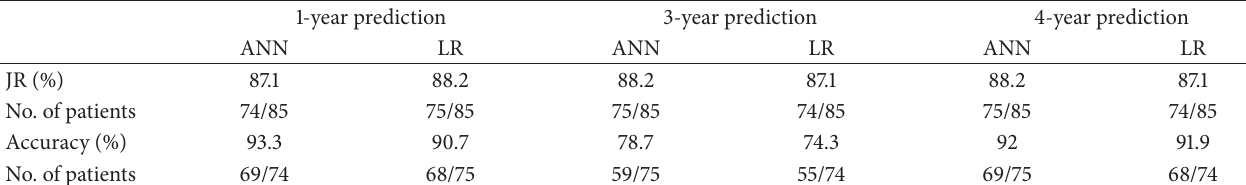
Table 3: Comparison of predictive models for 1-, 3-, and 4-year using ANN and LR.